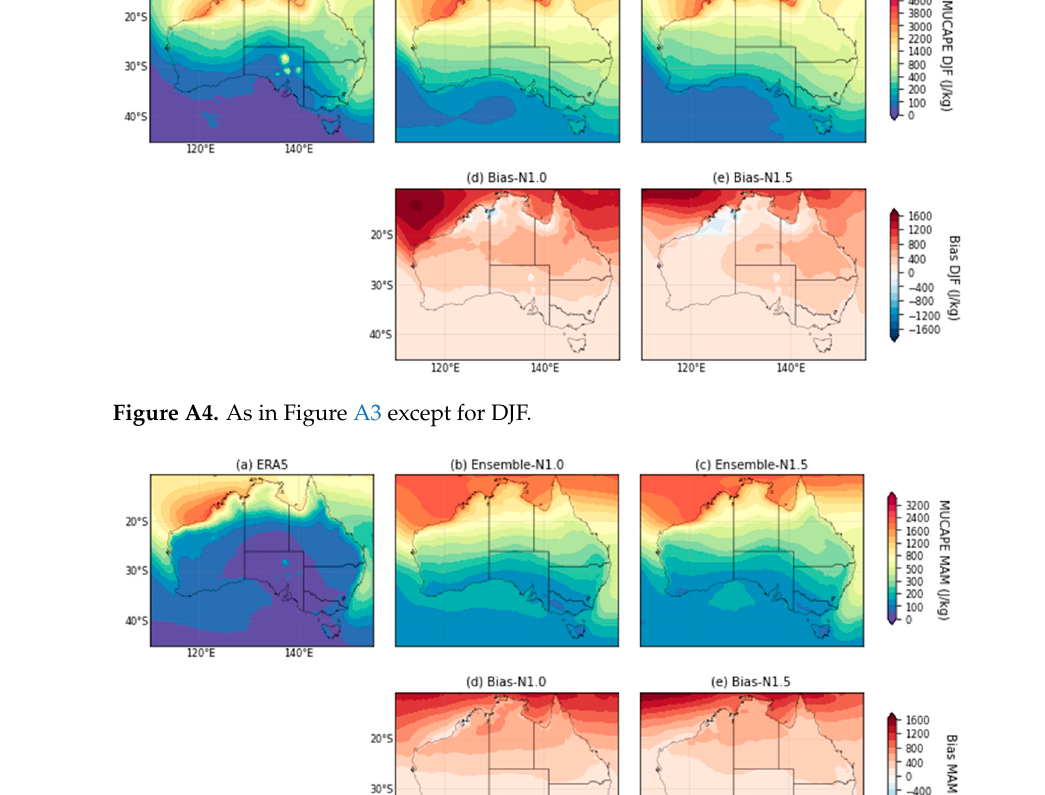
Figure A3. Climatology of MUCAPE in d01 from ( a ) ERA5, ( b ) N1.0 and ( c ) N1.5 during SON. ( d , e )